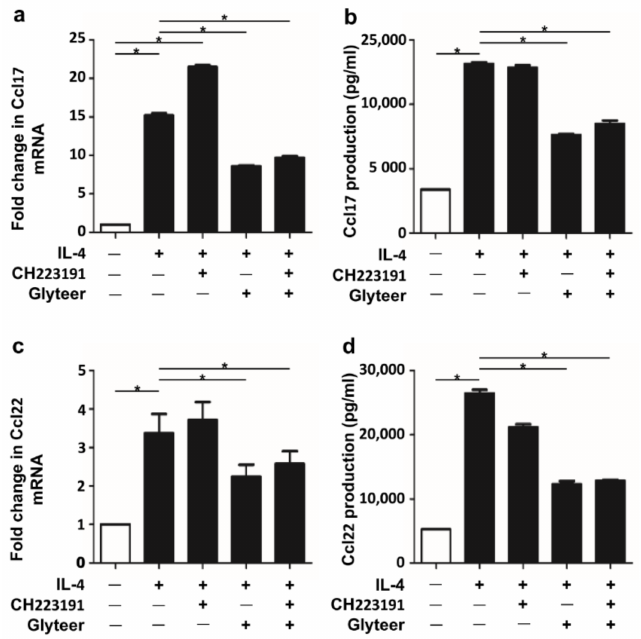
Figure 3. Glyteer treatment inhibited IL-4-induced Ccl17 and Ccl22 production in an aryl hydrocarbon receptor (Ahr)-independent manner in BMDCs. ( a – d ) Data are expressed as mean ± S.E.M.; n = 3 for each group; * p < 0.05. IL-4-stimulated BMDCs were treated with Glyteer in the absence or presence of CH223191 for 24 h. Glyteer and CH223191 were administered at the same timing. Expression of Ccl17 ( a ) and Ccl22 ( c ) in BMDCs was analyzed by qRT-PCR. Production of Ccl17 ( b ) and Ccl22 ( d ) in culture supernatant was measured by